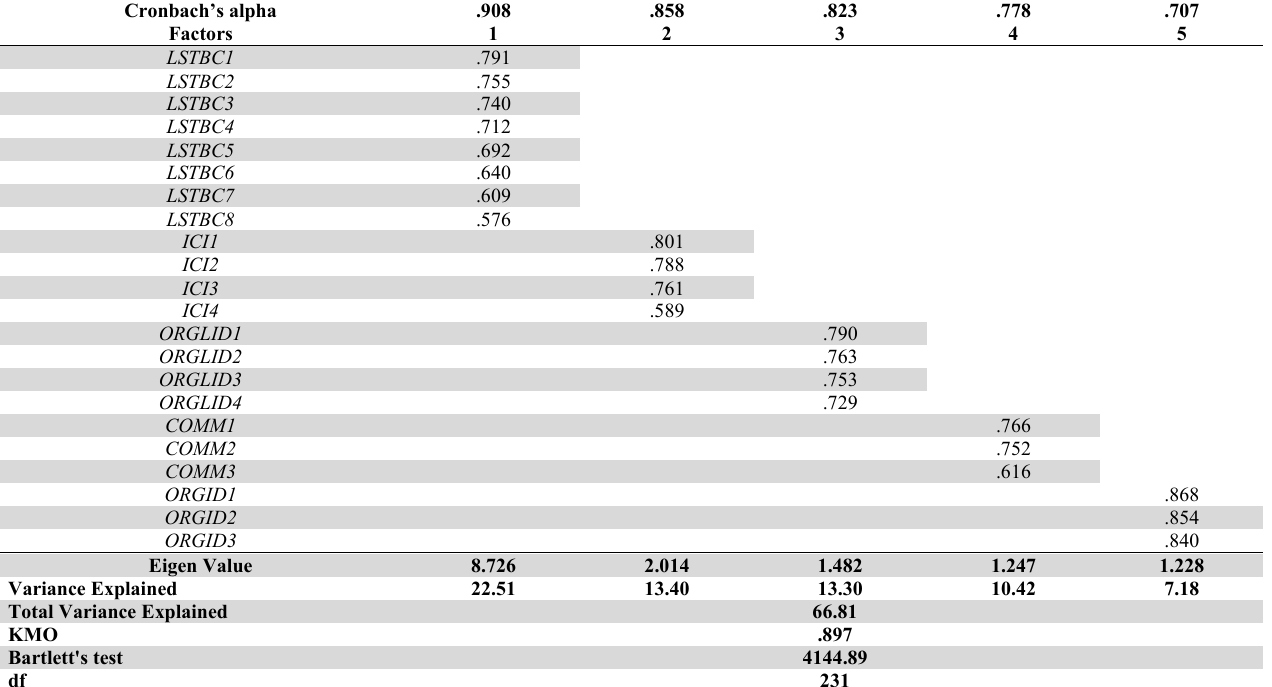
Study’s EFA and Cronbach’s